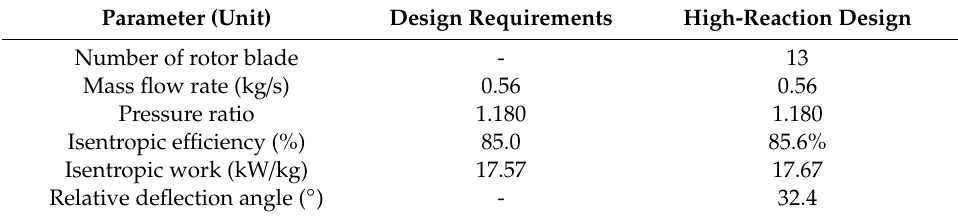
Table 5. CFD results of the performance of the high-reaction method tip turbine.